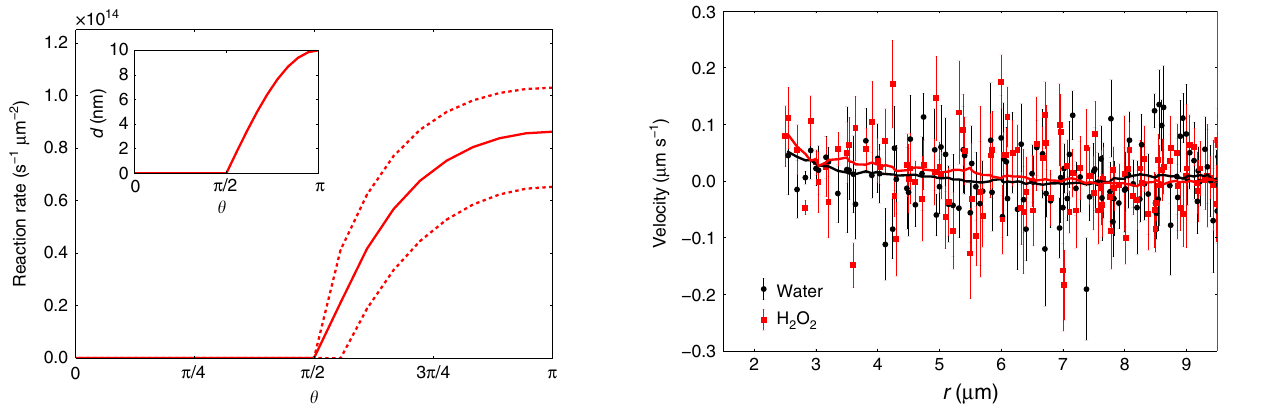
Fig. 2 Catalytical activity of the Janus colloid. Predicted variation in catalytic activity across the Janus sphere surface based on an exponential fi t to reactivity measurements reported in ref. 13 and geometrically determined variation in Platinum coating thickness (inset). The dashed lines represent ±1 standard deviation of the fi t used to interpolate the reactivity data in ref. 13